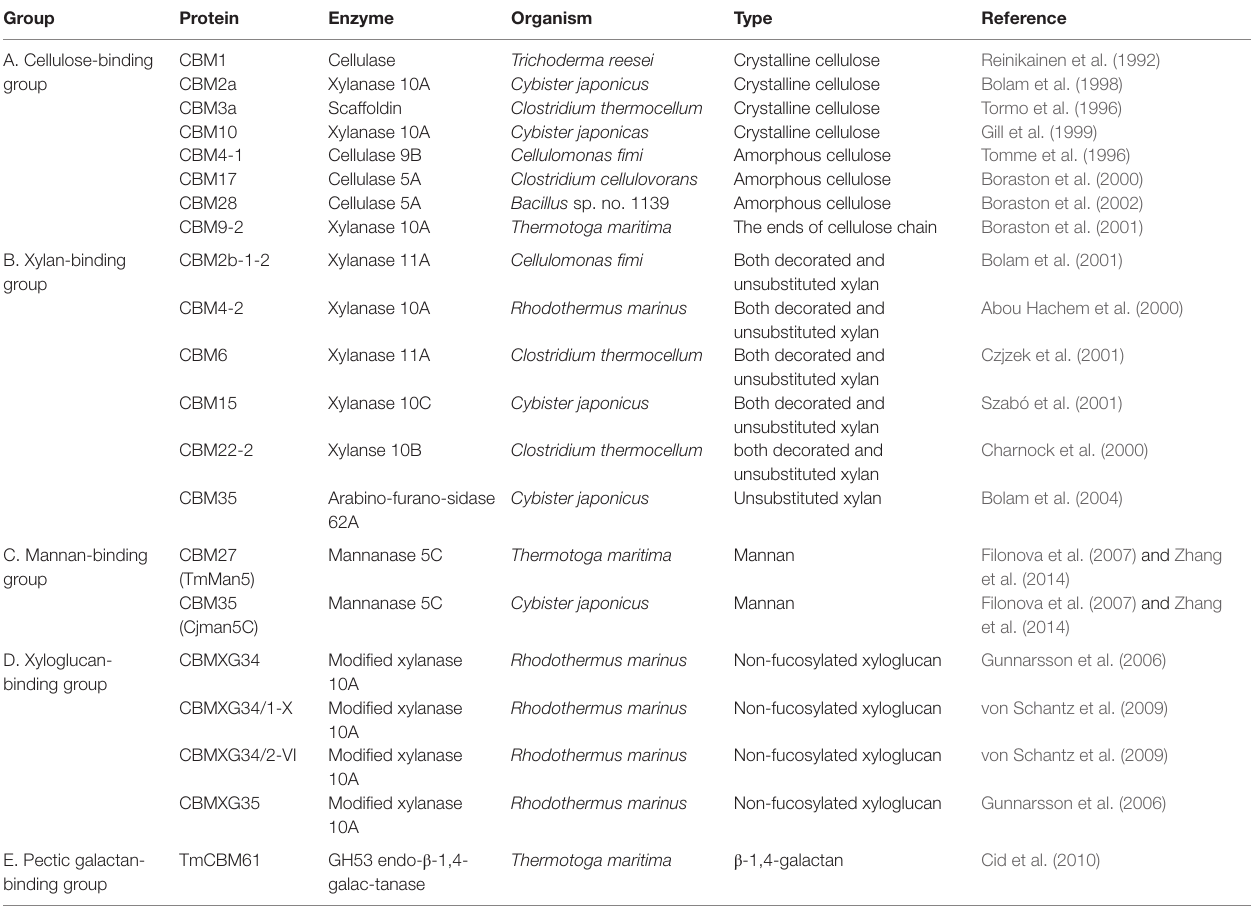
TABLe 1 | List of major CBMs currently used for plant cell wall analyses.